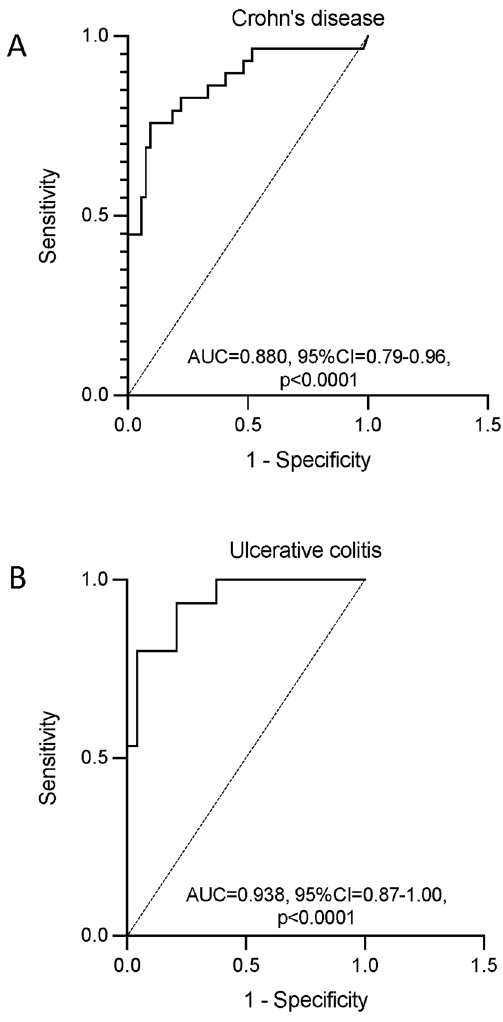
Figure 3. Receiver operator characteristic analysis for mean plasma OSM concentrations for CD ( A ) and UC ( B ) participants with and without clinical remission at 1 year on anti-TNF therapy ( B ). Oncostatin-M, OSM; Crohn’s disease, CD; ulcerative colitis, UC; area under the curve (AUC); confidence interval (CI).